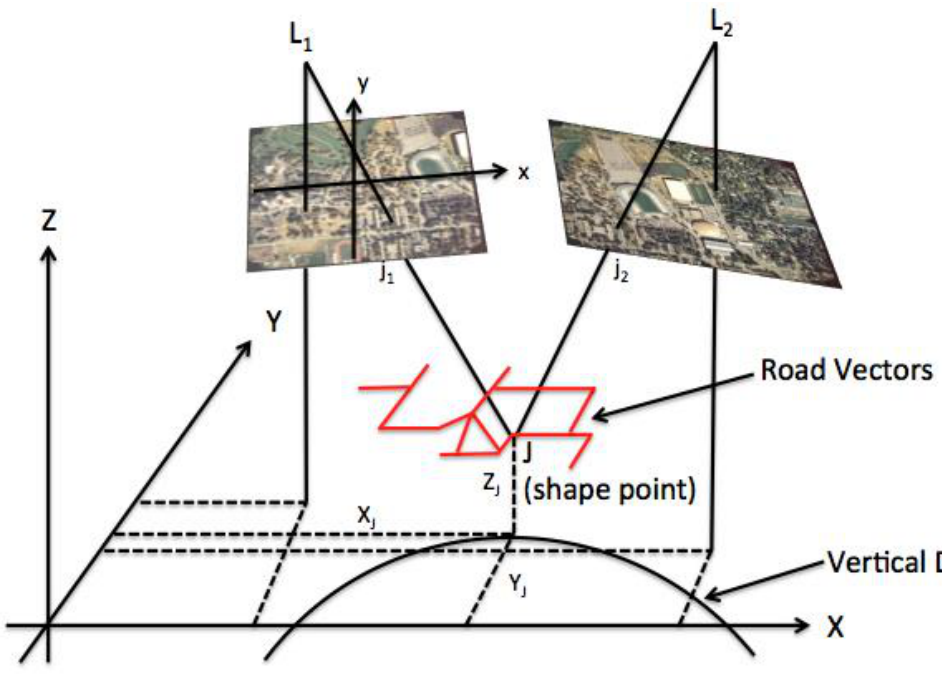
Figure 3. Geometric diagram of the vector adjustment